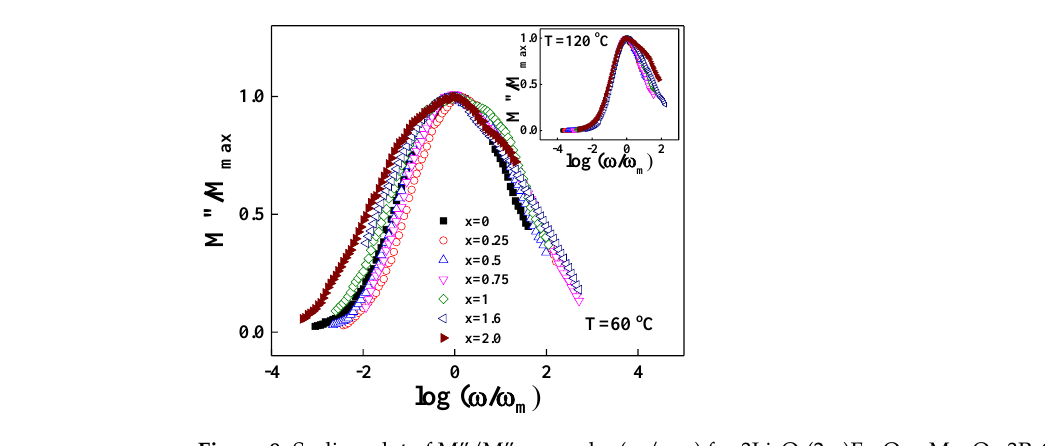
Figure 8. Scaling plot of M”/M” max vs. log(ω/ω m ) for 3Li 2 O-(2-x)Fe 2 O 3 -xMn 2 O 3 -3P 2 O 5 (x = 0, 0.25, 0.5, 0.75, 1.0, 1.6, 2.0) glasses at 60 °C. Inset corresponds to the scaling plot at 120 °C.